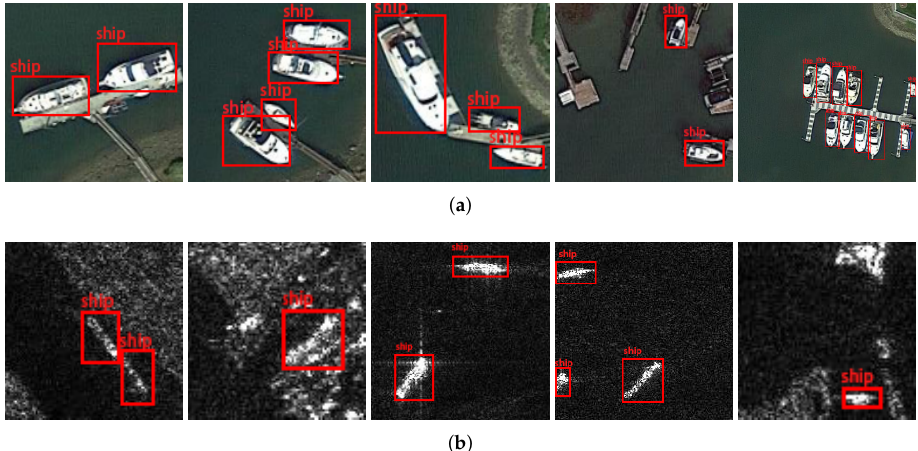
Figure 1. Examples of optical and SAR images, with the ship target marked by the red rectangle. ( a ) Optical images. ( b ) SAR